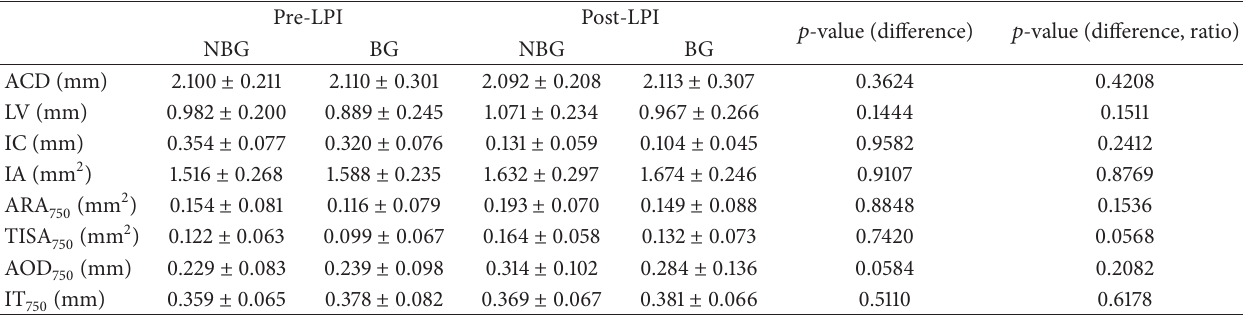
Table 2: Mean difference in the AS-OCT parameters in the two study groups at pre- and